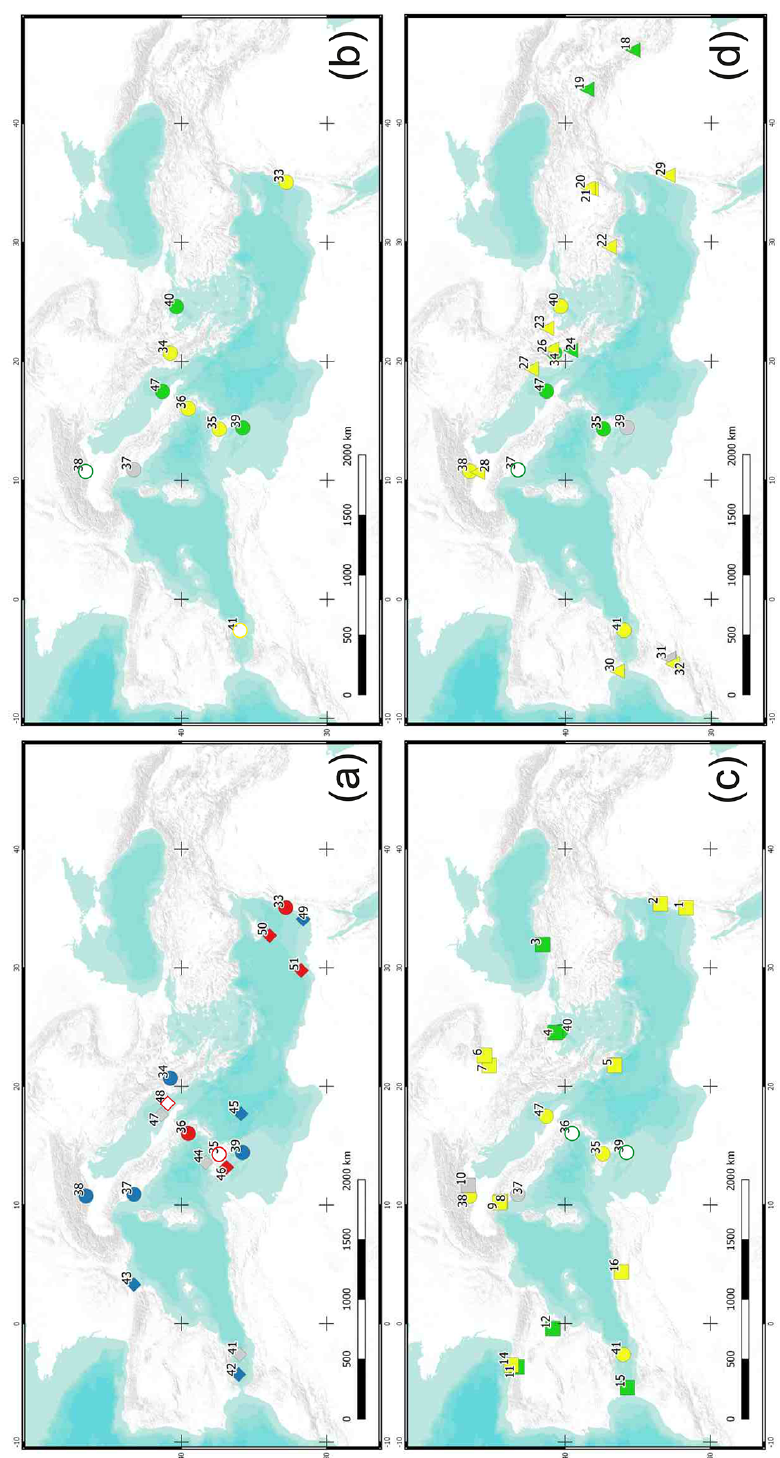
Figure 8. Maps of (a) annual average temperature, (b) annual average precipitation, (c) winter precipitation, and (d) summer precipitation. See Figs. 2–5 and Table 1 for data. Circles indicates data from pollens, lozenges indicate data from alkenones, squares indicate data from speleothems, and triangles indicate data from the lake. Meaning of filled symbols: blue indicates colder conditions, red indicates warmer conditions, yellow indicates drier conditions, green indicates wetter conditions, and grey indicates unchanged conditions; unfilled symbols: symbols with a red border indicate likely warmer conditions, those with a yellow border indicate likely drier conditions, and those with a green border indicate likely wetter